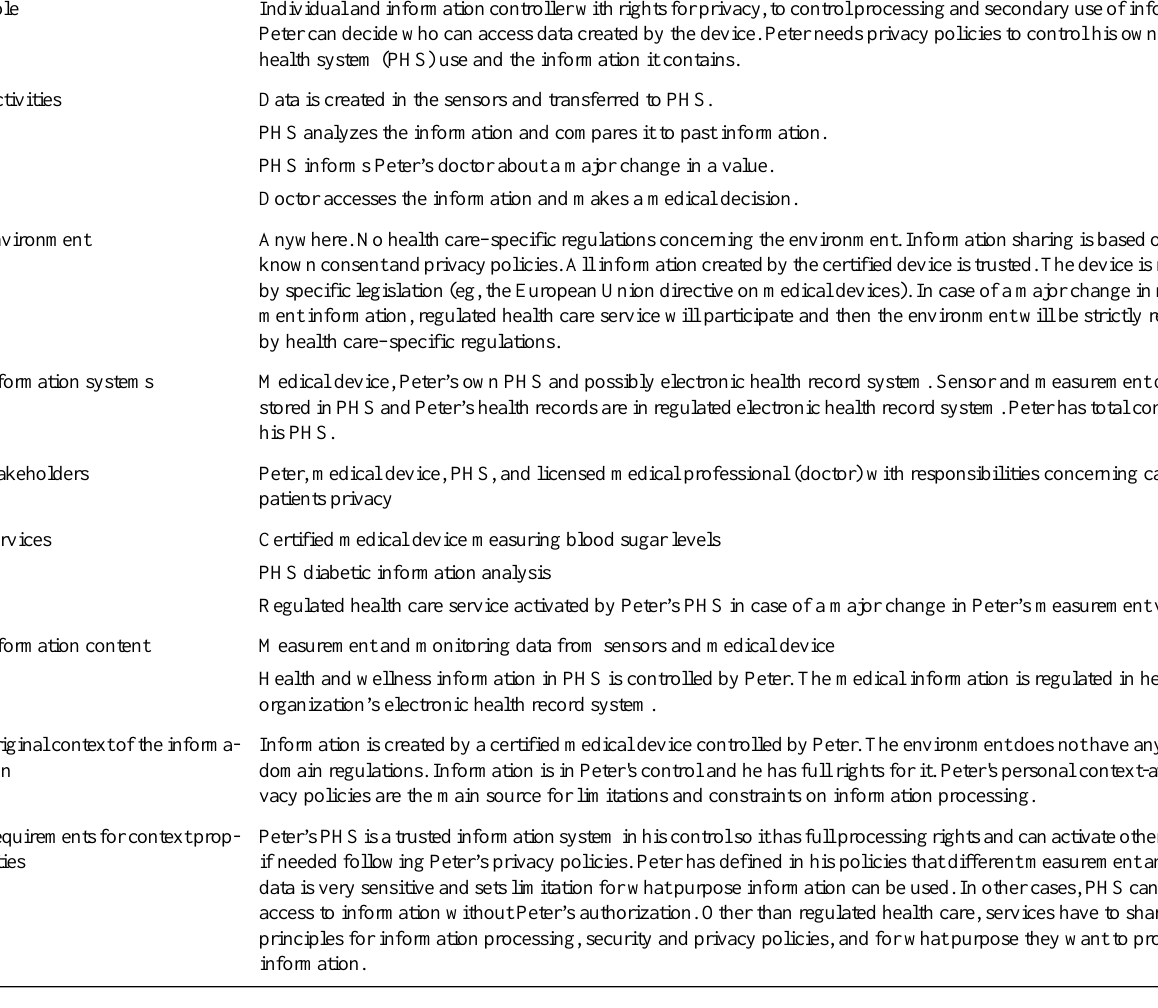
Table 1. An example analysis of a user story in chronic disease scenario. User story 2.1: Peter receives a medical device with sensors to manage and care for his disease and automatically measure and monitor his condition. Devices can also automatically inform his doctor about the results and major